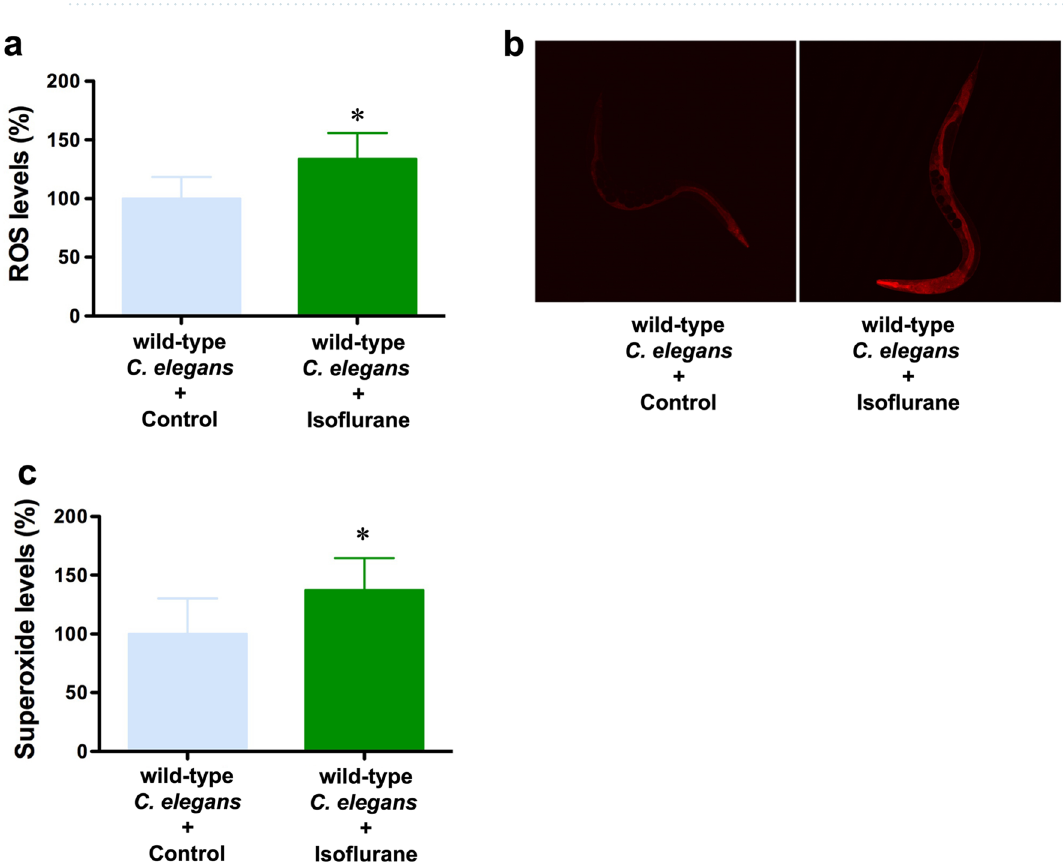
Figure 3. Isoflurane increased ROS levels in wild-type C. elegans . ( a ) Isoflurane increased the levels of ROS in C. elegans as compared to the control condition. ( b ) Superoxide staining by MitoSOX shows an elevated level of superoxide of C. elegans following the treatment with isoflurane and control conditions. ( c ) The quantification of the staining showed that the isoflurane treatment (green bar) increased the level of superoxide compared to the control condition (blue bar) in C. elegans . All data are presented as mean ± S.D. N = 10 hermaphrodites in each group. The Student’s t-test was used to analyze the data presented in ( a , c ); the P values refer to the difference between the control condition and isoflurane. * P <